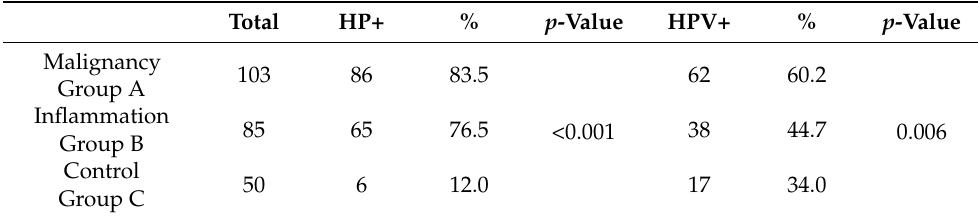
Table 1. Absolute and percent occurrence of Helicobacter pylori and human papillomaviruses in the malignancy, chronic inflammation, and control groups. Total